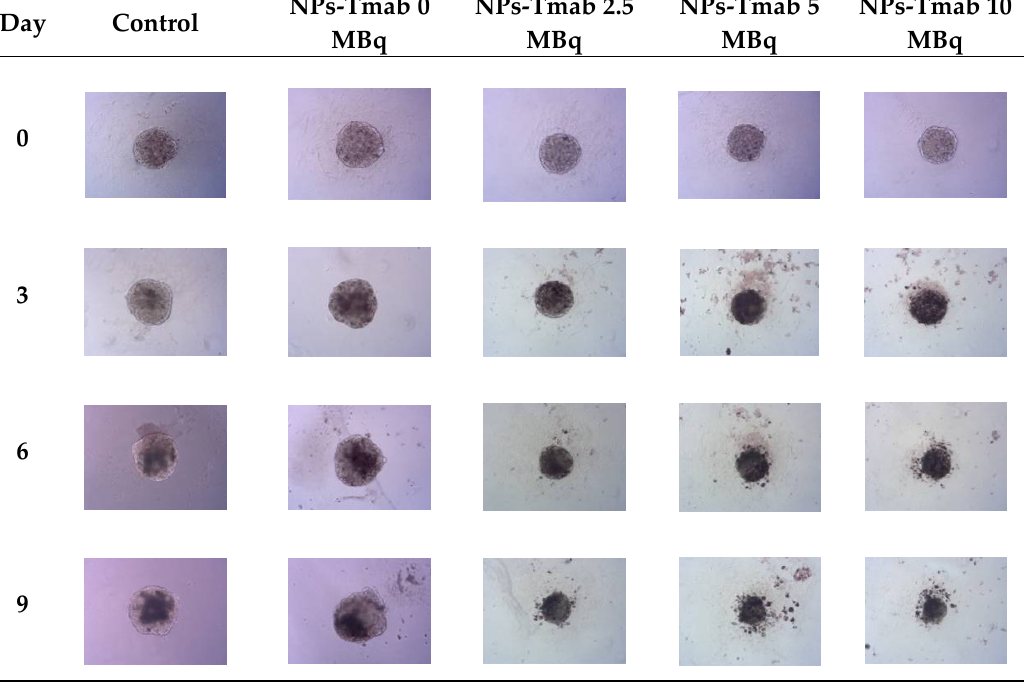
Figure 9. Microscope images of representative spheroids. Images made for spheroids incubated for 1 h with radioactive NPs-Tmab on the day of treatment (Day 0) and on Days 3, 6, and 9 after treatment. Images were acquired with Primovert microscope equipped with Axiocam 105 color (Zeiss, Jena, Germany) with ZEN 2.3 lite software (Zeiss, Jena, Germany), 5× magnification.